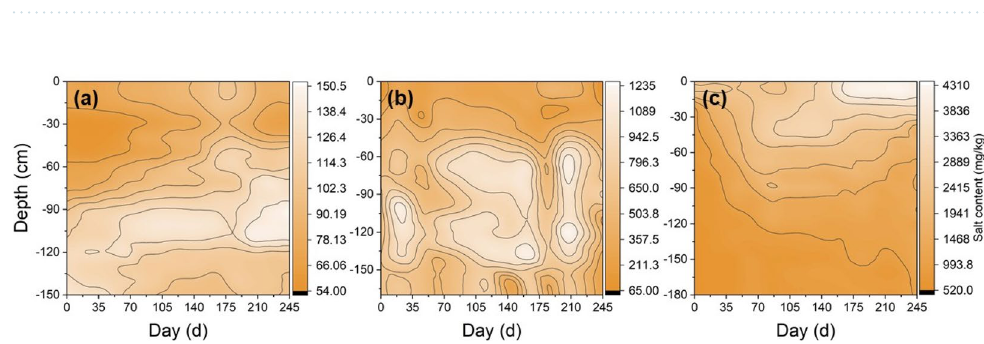
Figure 6. Dynamics of soil water storage change rate ( WSCR ) of four soil layers in farmland, LT grassland and AS land.